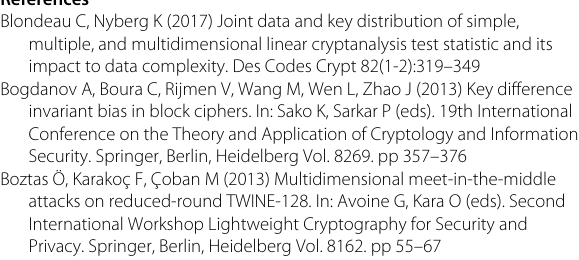
ear subspace with key difference invariant bias